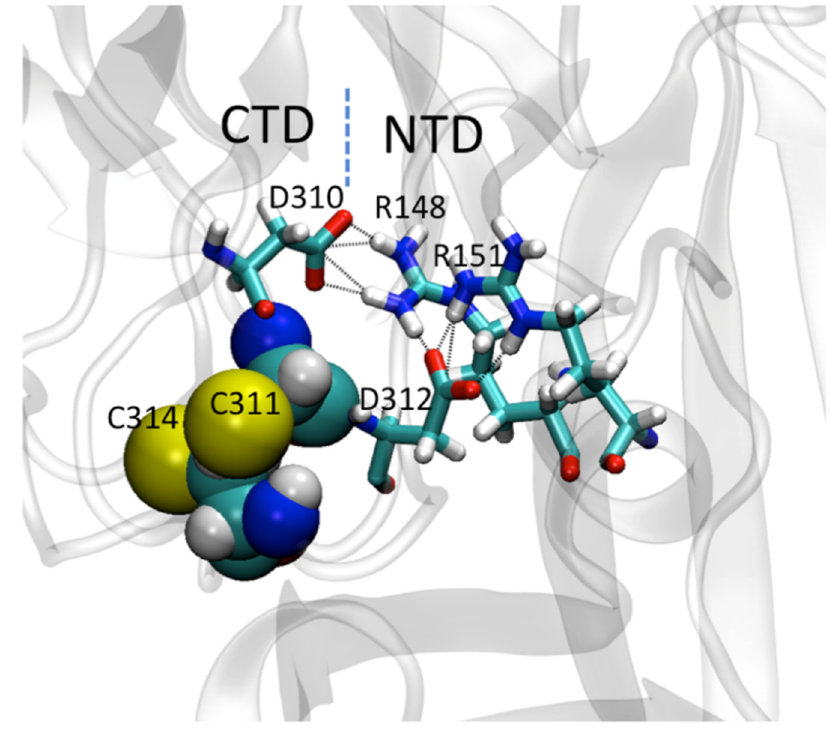
Figure 7. Molecular dynamics simulations reveal interdomain salt-bridges between Asp and Arg residues in the CTD and NTD, respectively. Aspartate residues (310 and 312) on either side of Cys 311 are involved in the interdomain salt-bridges between N-and C-terminal domains.